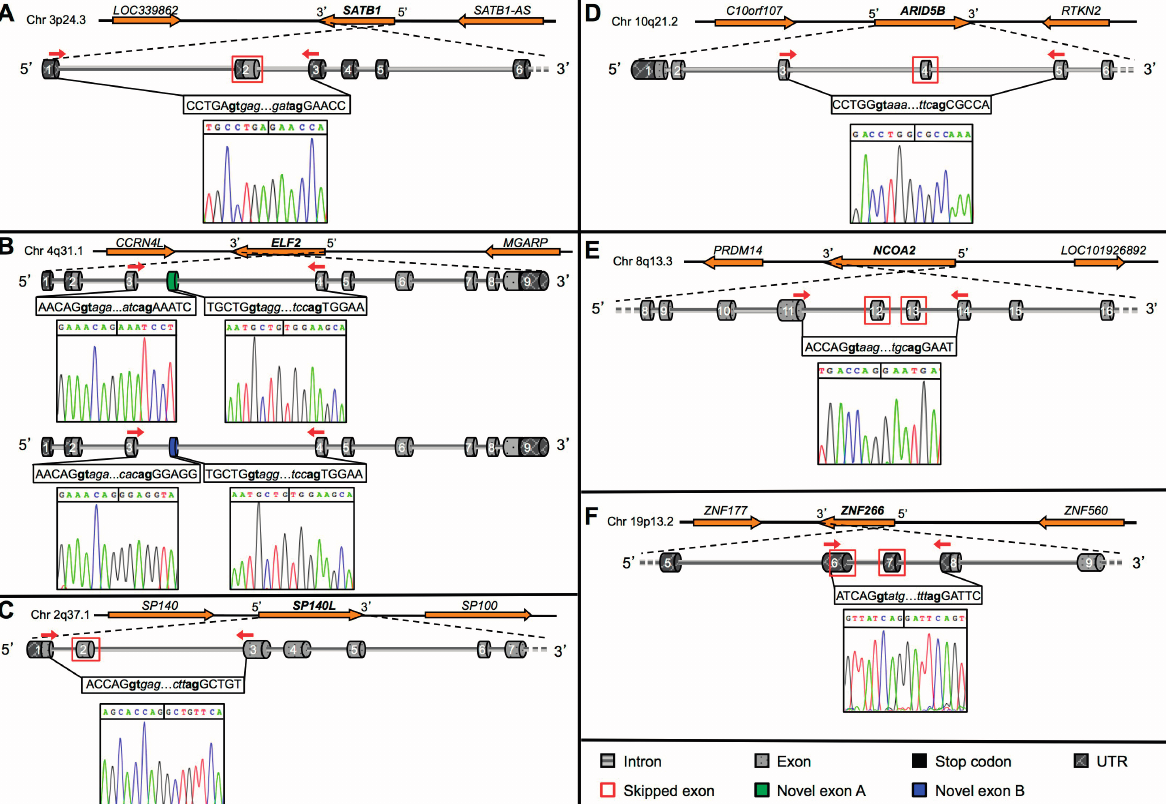
Figure 3. Graphical representation of newly identified splicing events in TF